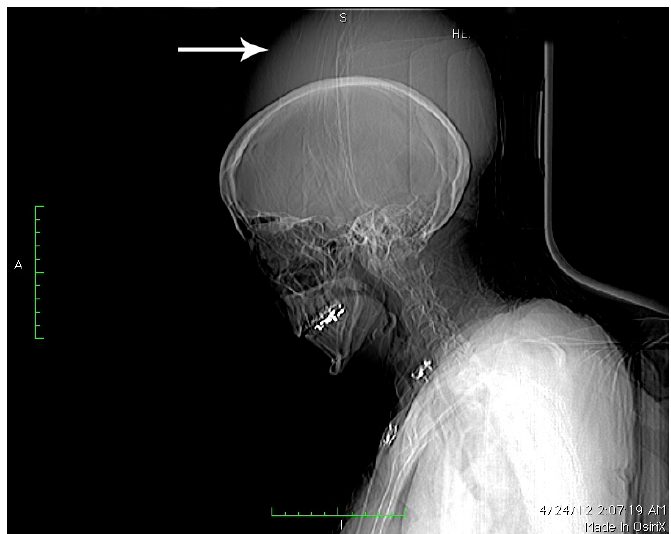
Figure 1. Computed tomography scout film demonstrating